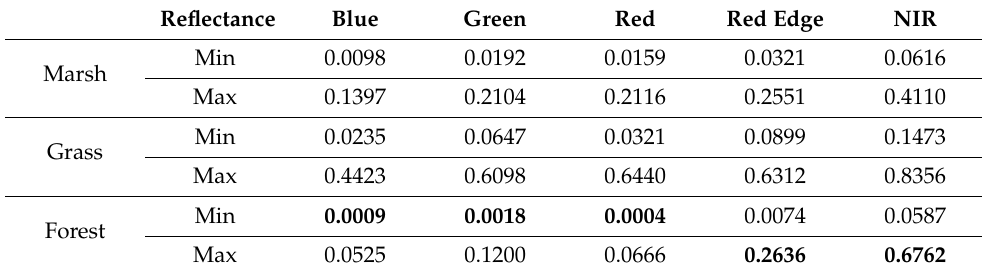
Table 6. The min-max ranges of the corrected reflectance images for marsh, grass, and forest. The extreme values are highlighted in bold.